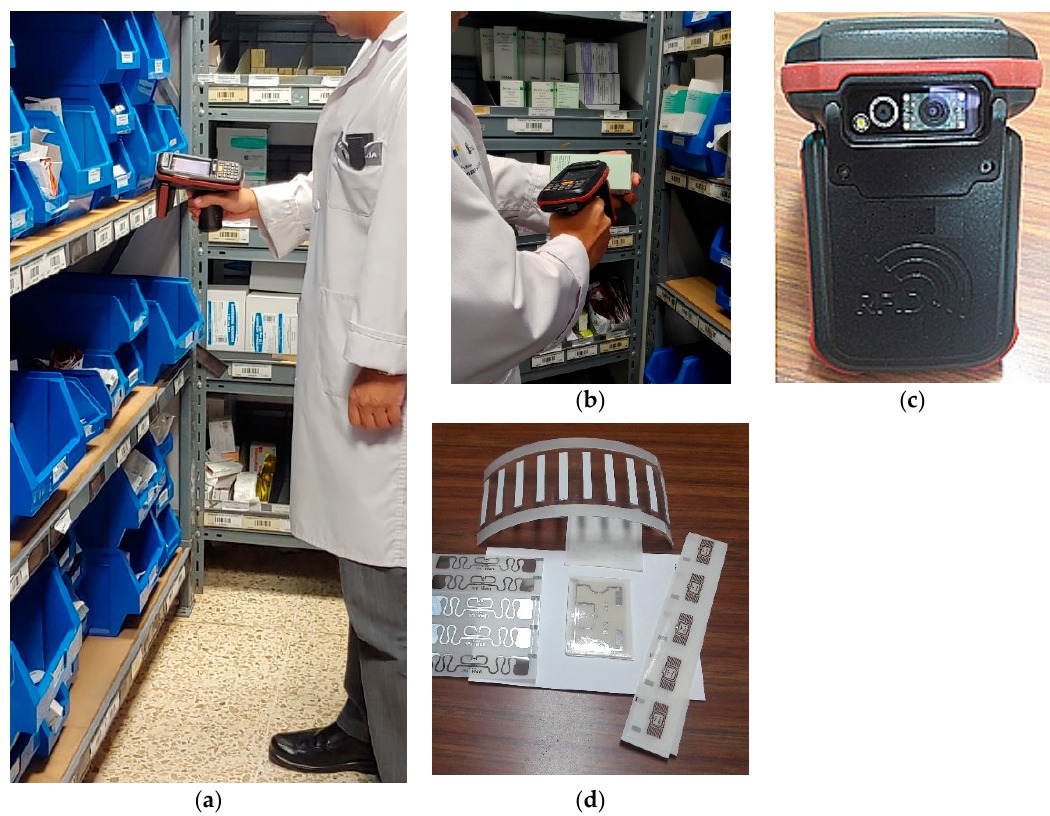
Figure 1. Examples of a handheld UHF RFID gun reader and tags: ( a,b ) the position of the operator scanning wares marked by RFID tags, ( c ) RFID gun, ( d ) RFID tags.